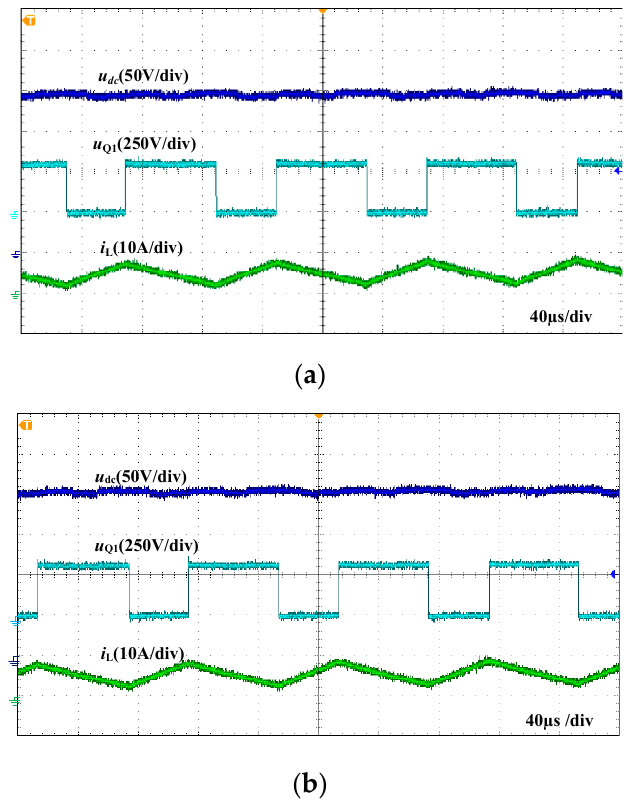
Figure 11. Experiment waveforms of the ripple of i L and the ripple of u DC in each switching cycle: ( a ) the estimation method; ( b ) the proposed method.